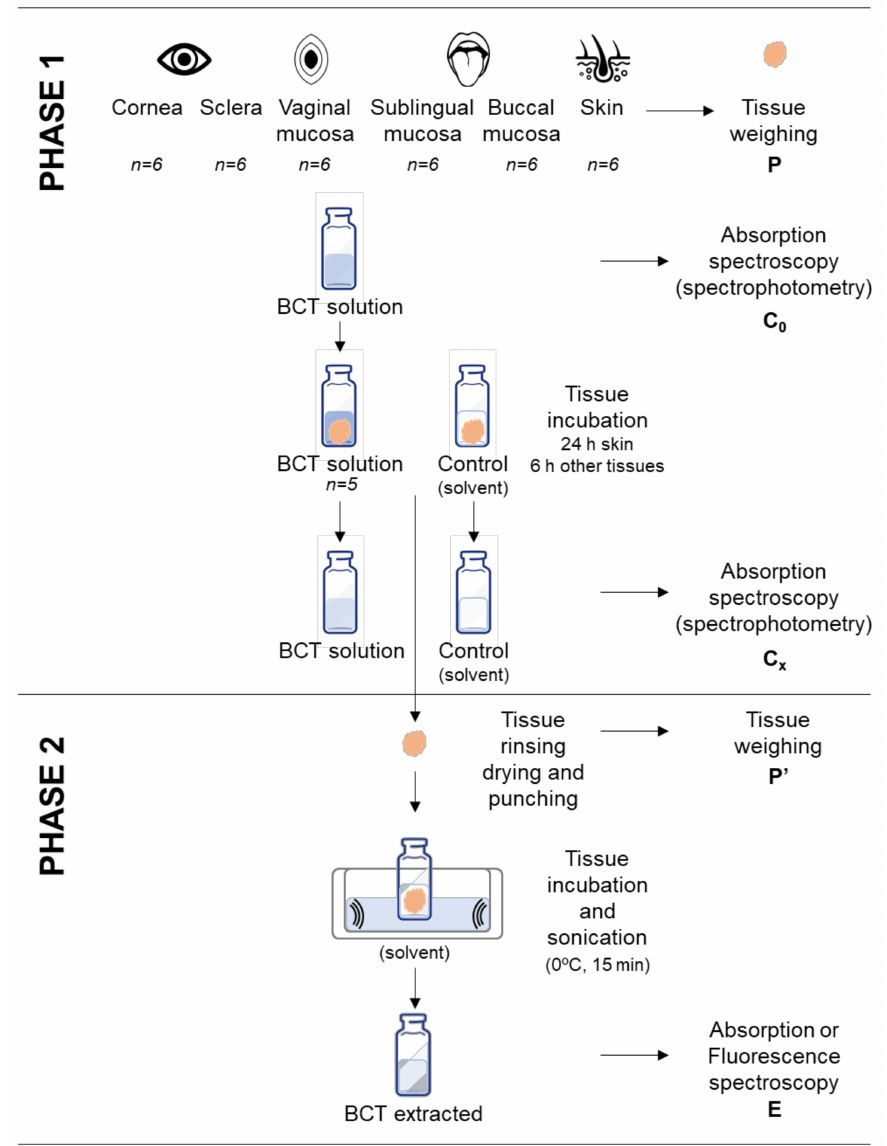
Figure 2. Schematic representation of the recovery process comprising phase 1 (drug uptake) and phase 2 (drug extraction). Samples consisted of pieces of tissue incubated in a solution of baricitinib, and the controls were tissues incubated in the solvent without baricitinib so as to evaluate any interference from the tissue with the analytical